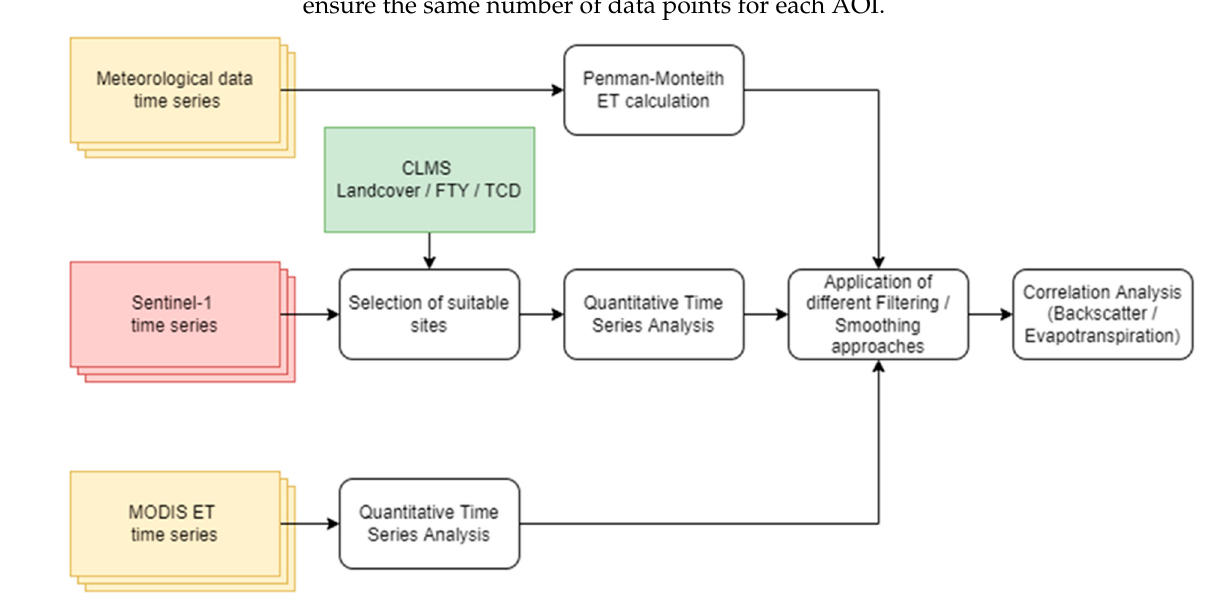
Figure 5. Workflow of the main analyses in this study (CLMS: Corine Land Monitoring Service; FTY: Forest Tree Type; TCD: Tree Cover Density).